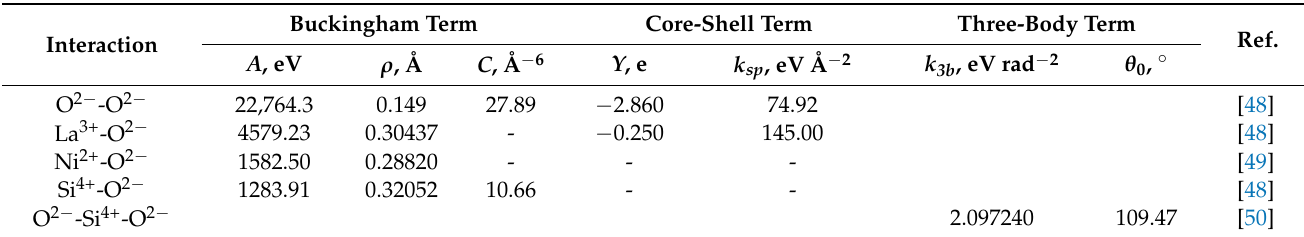
Table 1. Interatomic potentials used for the lattice